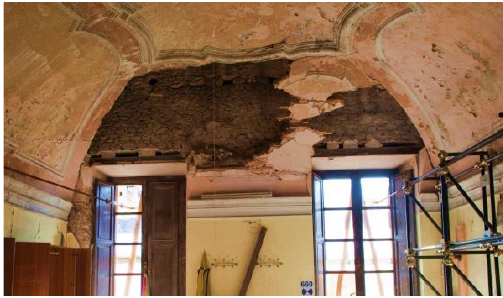
Figure 3. The thin vault tested in the city of L’Aquila.